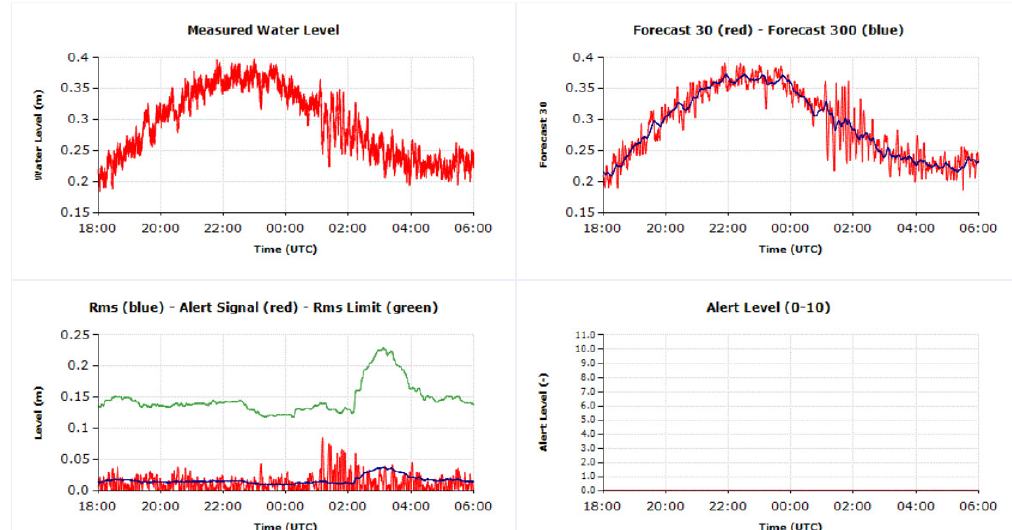
Figure 12. Results of the measurements and the calculated quantities from the Marina di Teulada IDSL during the event. The image is a screenshot of the published web data, which appeared online during the event.